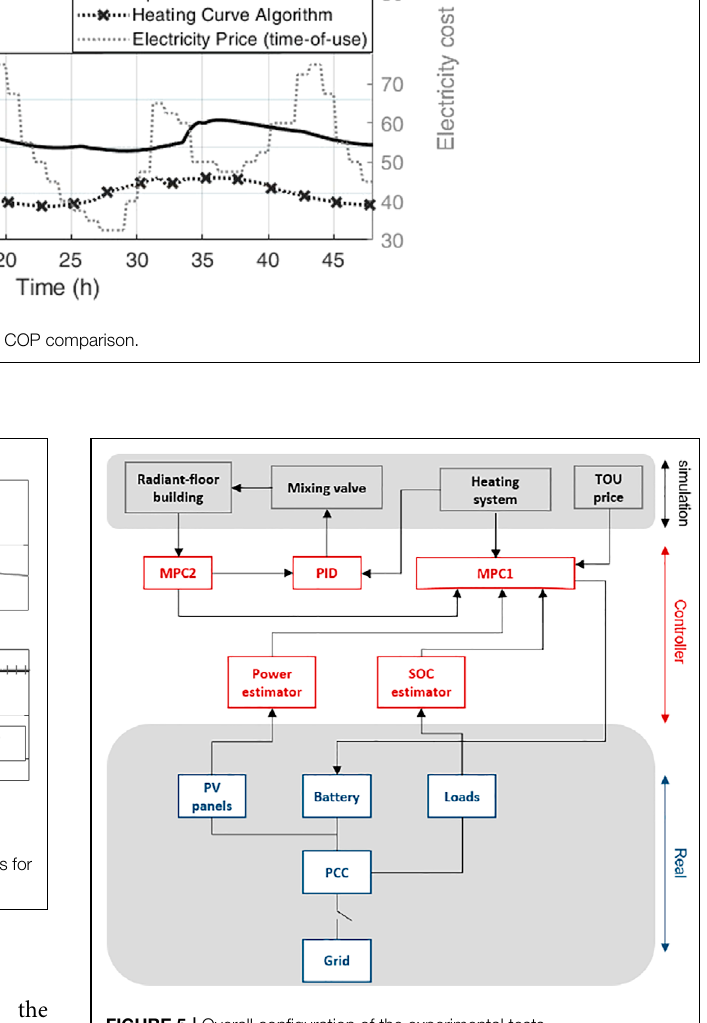
FIGURE 5 | Overall configuration of the experimental